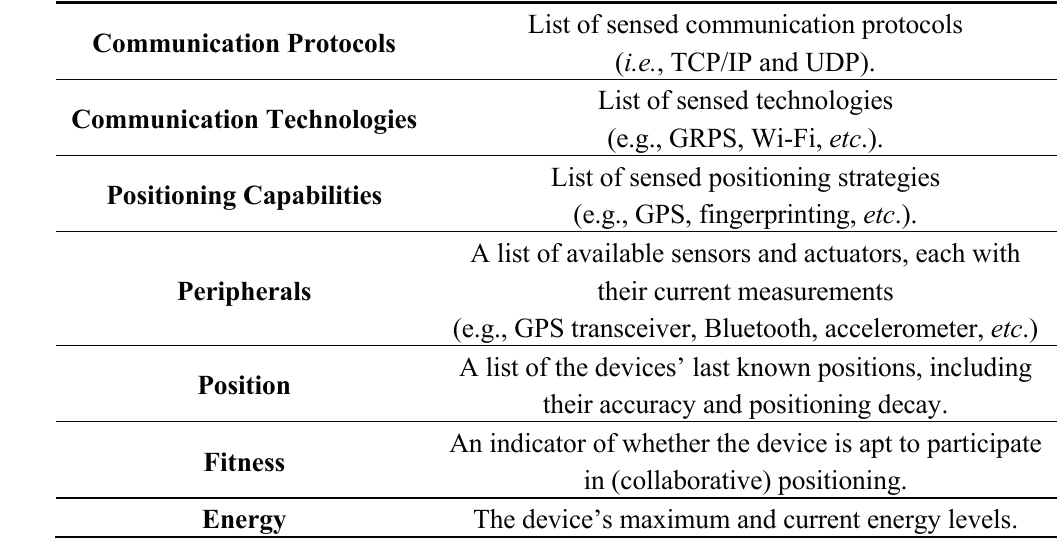
Table 1. Devices feature